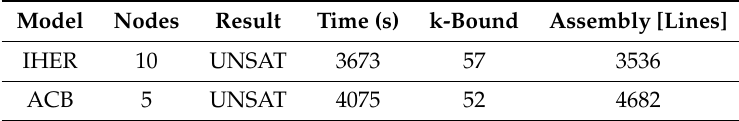
Table 3. Verification result of program 1.